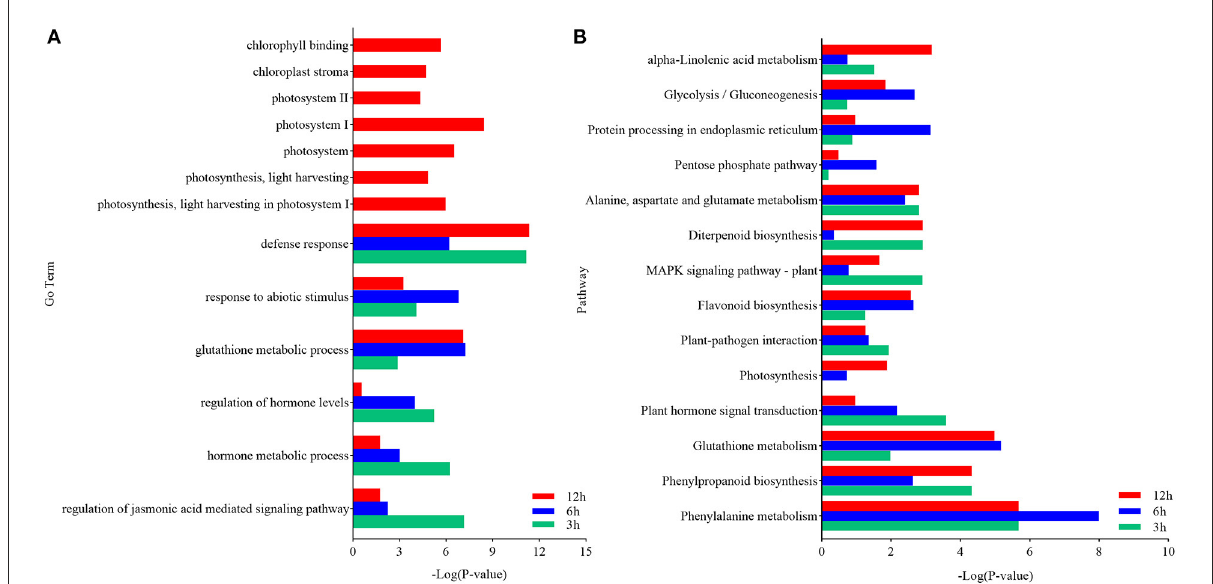
FIGURE4 Functional analysis of DEGs in maize inoculated with Ustilago maydis . (A) GO enrichment analysis was executed with DEGs identified between control (CK) and inoculated samples (Inf). The ordinate and abscissa represent the main biological process GO terms and -Log ( P -value), respectively. (B) Pathways significantly enriched with the DEGs identified between CK and Inf samples at the various time points after inoculation. The ordinate and abscissa represent the major KEGG biological pathways and -Log ( P -value), respectively. The green bars represent CK 3h vs. Inf 3h; the blue bars represent CK 6h vs. Inf 6h; the red bars represent CK 12h vs. Inf